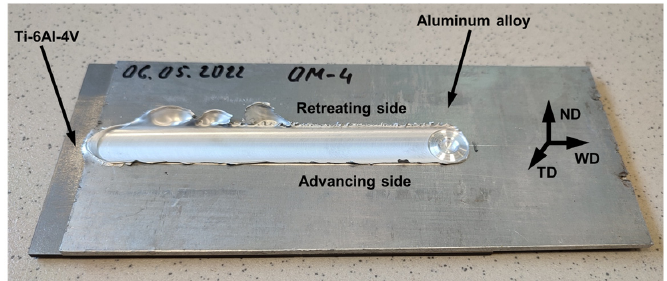
Figure 1. Typical appearance of welded joints. ND, WD, and TD are normal direction, welding direction, and transverse direction, respectively. Note: The photo was taken from the welded joint of AA6013 alloy produced at a welding speed of 50.8 mm/min.